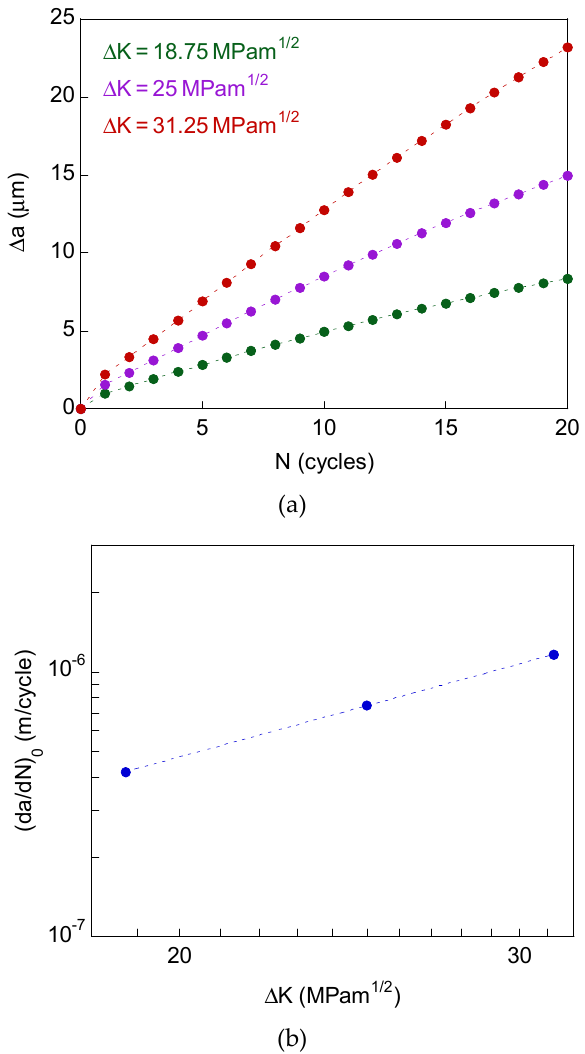
Figure 3. Plastic fatigue propagation for straight crack tip: ( a ) crack growth vs . number of cycles; ( b ) crack growth rate vs . SIF range (Paris curve).